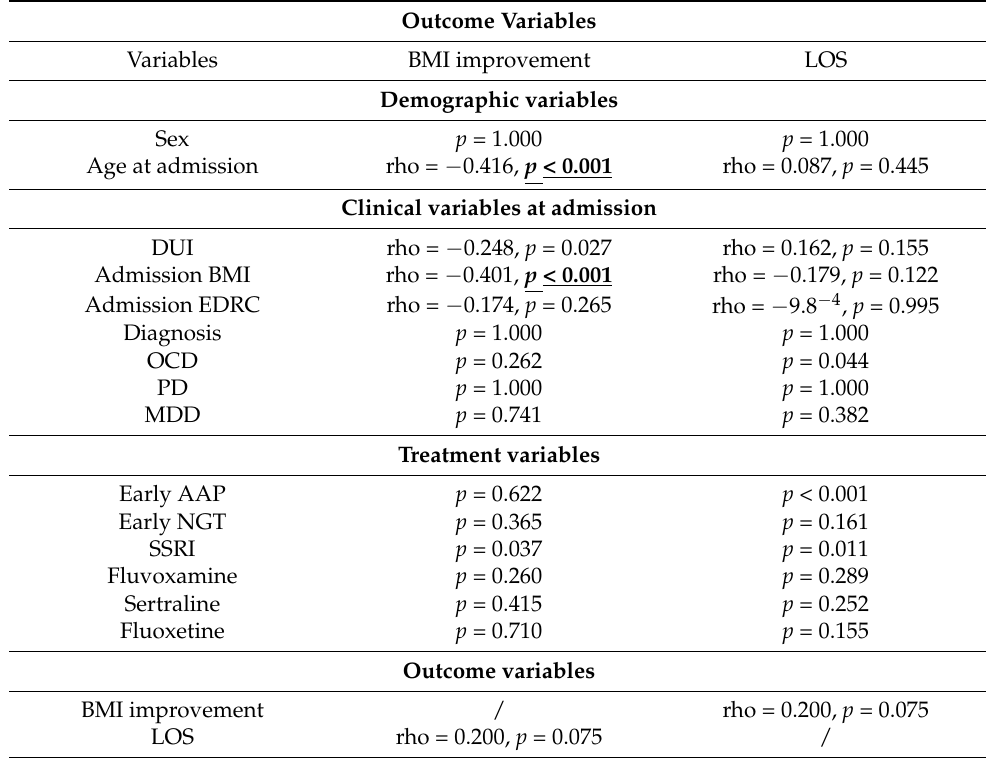
Table 2. Correlations between outcome variables and demographic, clinical, treatment and outcome variables. Outcome Variables Variables BMI improvement